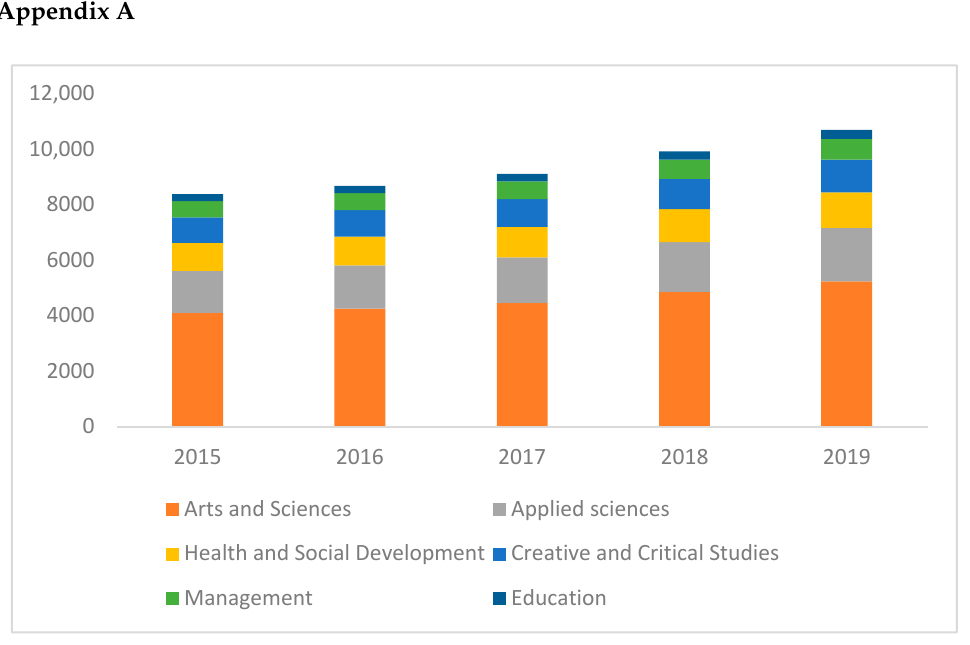
Figure A2. Heating degree days and cooling degree days. Table A1. Buildings investigated in this research. Building